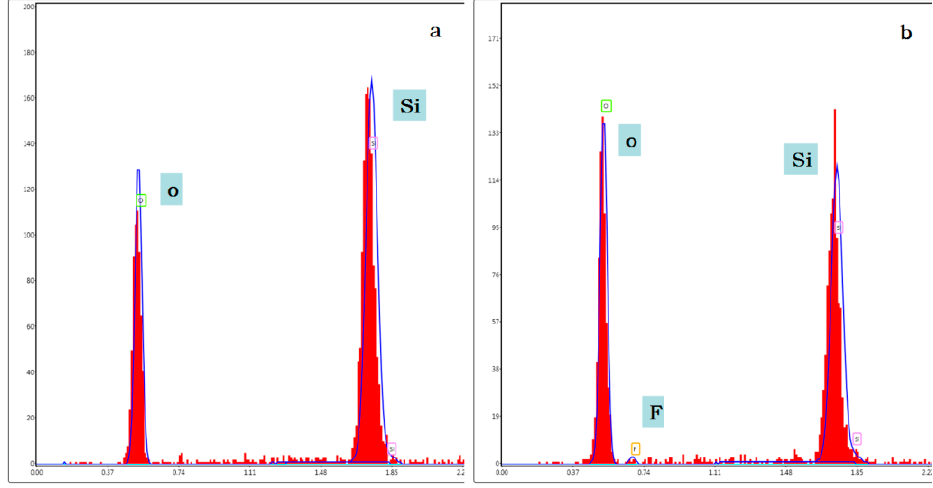
Figure 9. The energy-dispersive spectroscopy (EDS) spectra of the quartz crystal sheet surfaces. ( a ) Uncovered sheets; ( b ) Sheets covered with FAS film.